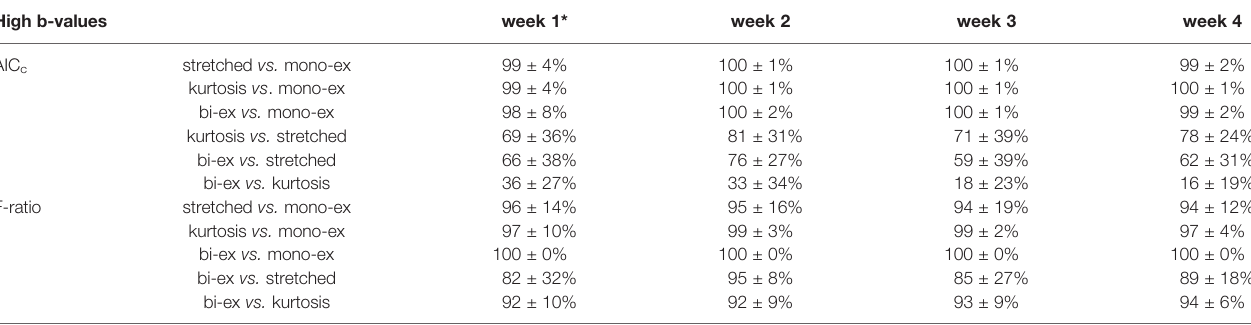
TABLE 2 | Mean ± standard deviation of median percentage values per mouse described better by the fi rst model of the comparison is shown in the table for DWI data obtained using high b-values. High b-values week 1* week 2 week 3 week 4 AIC c stretched vs. mono-ex 99 ± 4% 100 ± 1%